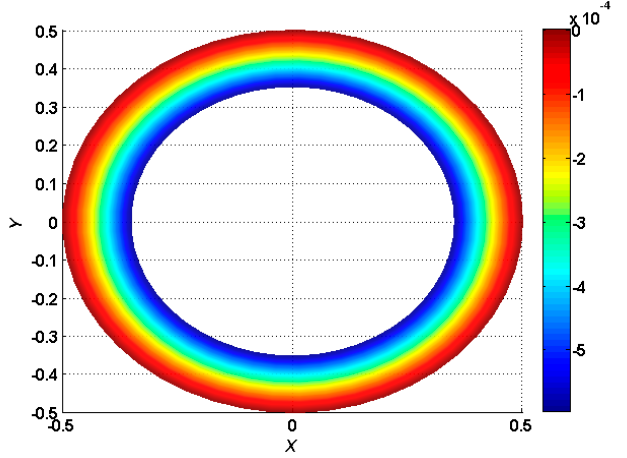
with torus 0.7 h R = and fully clamped w wE h q = Al ,